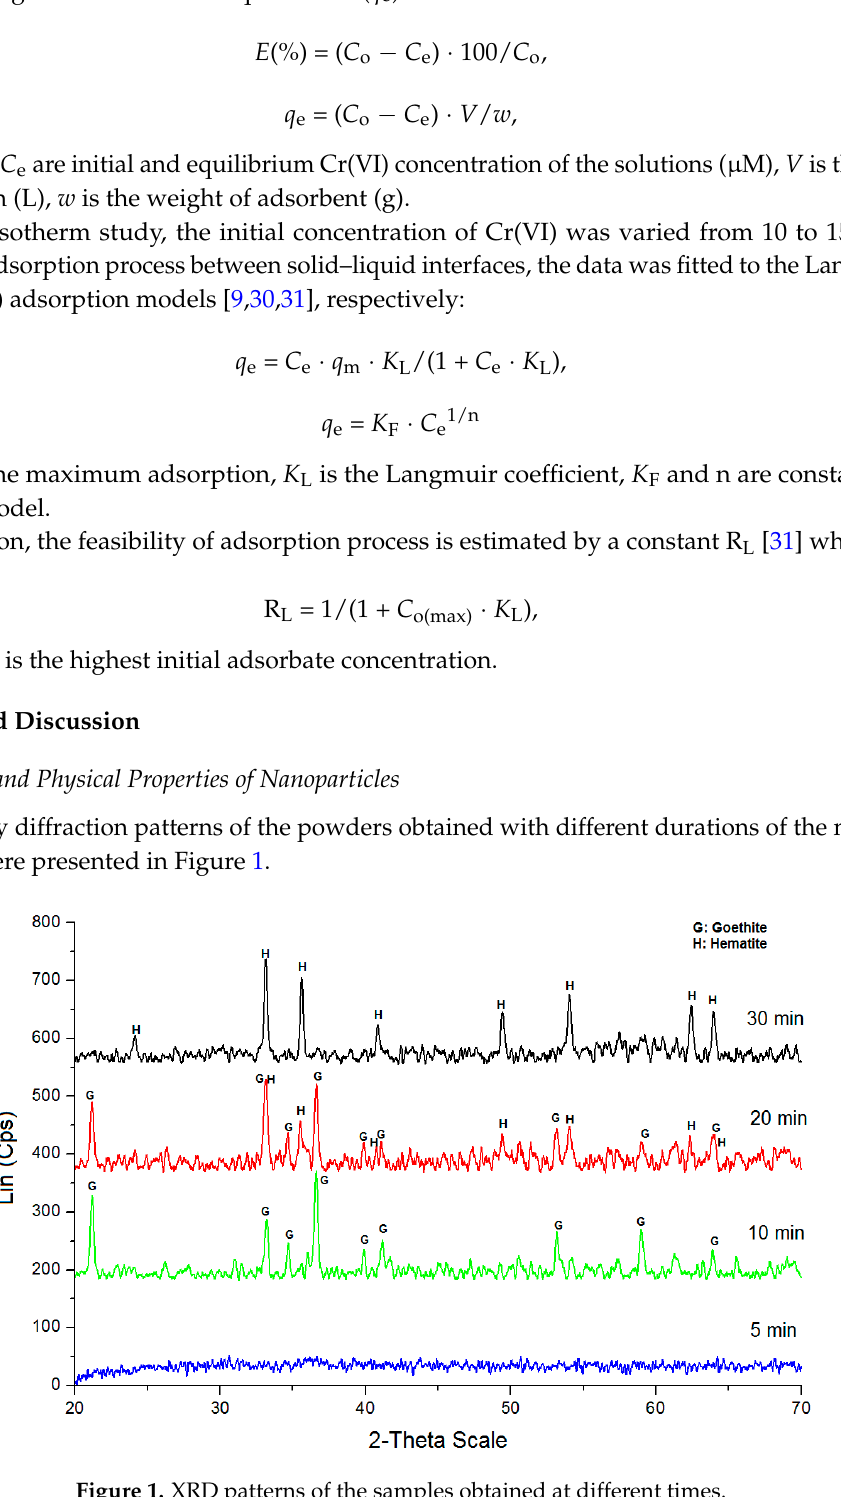
Figure 1. XRD patterns of the samples obtained at different times.